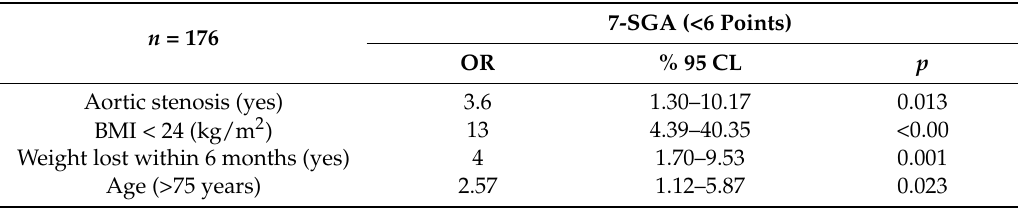
Table 7. Logistic regression analysis: factors related to the deterioration of nutritional status and poor appetite in all subjects. n =